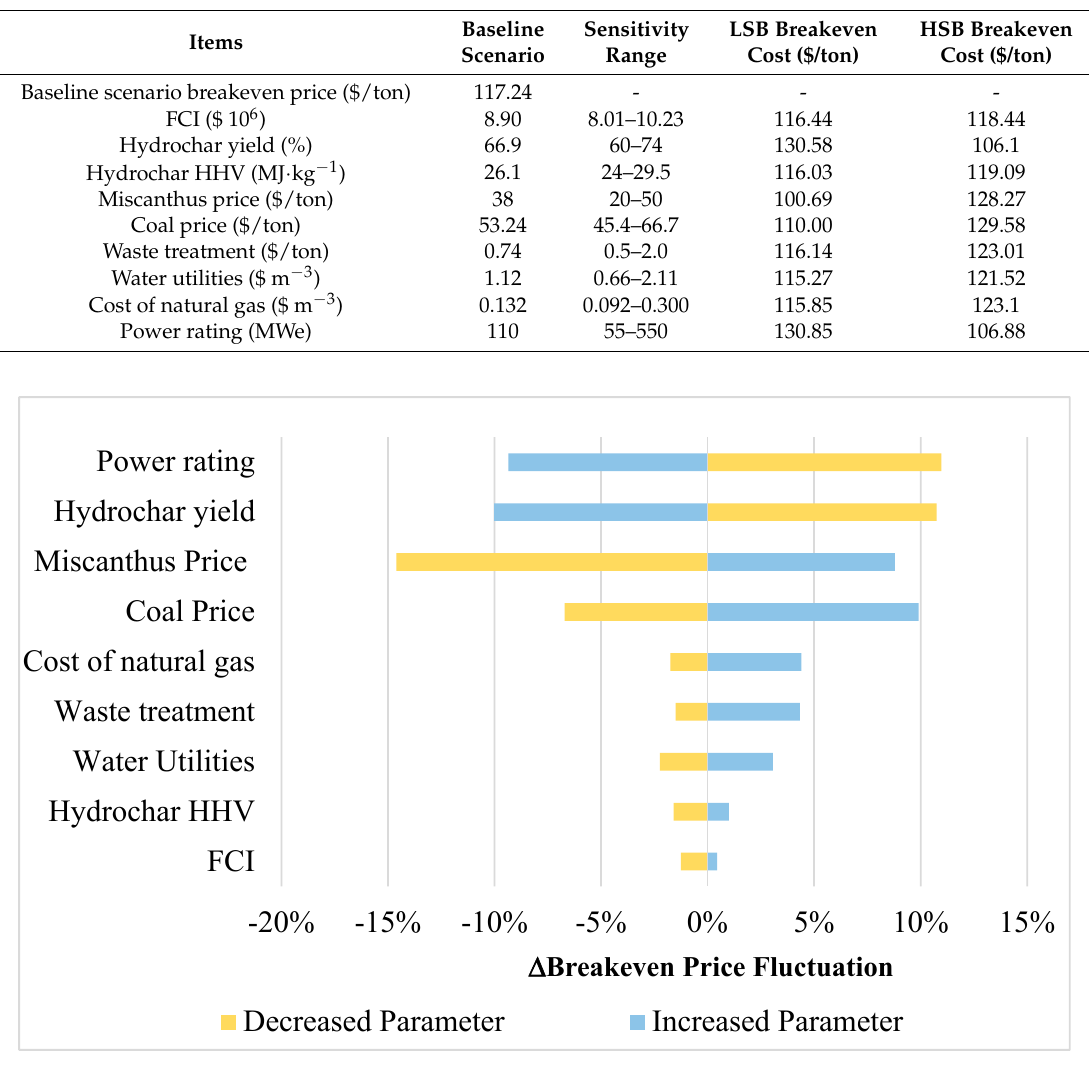
Figure 2. Sensitivity analysis showing change in breakeven price of product with respect to baseline breakeven cost.